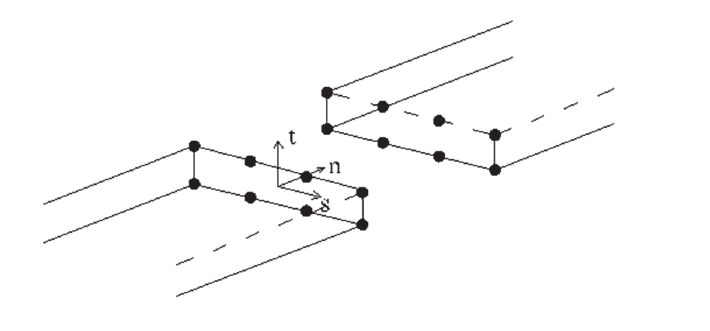
Figure 4: Masonry-masonry interface and local reference